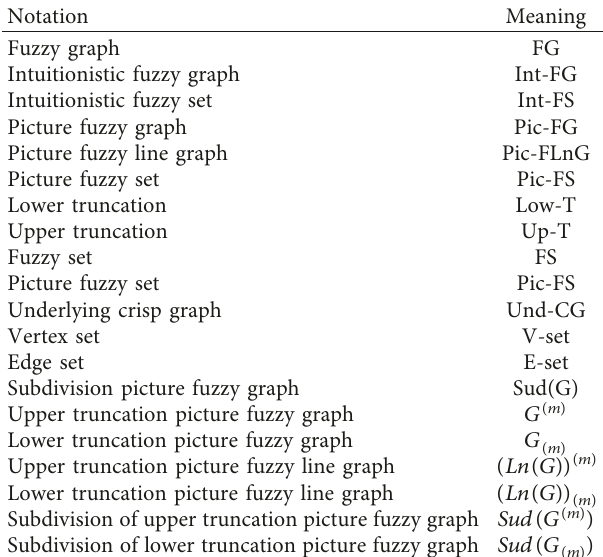
Table 1: Some basic